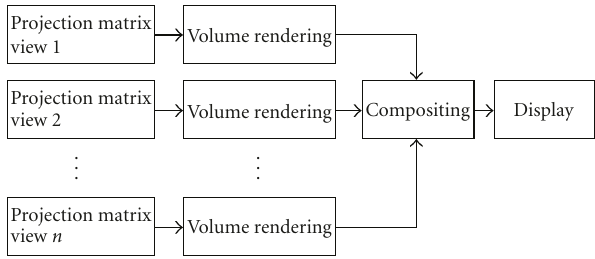
Figure 4: The process of rendering for the lenticular display. Optionally, the rendering of the n individual views can be done in parallel.